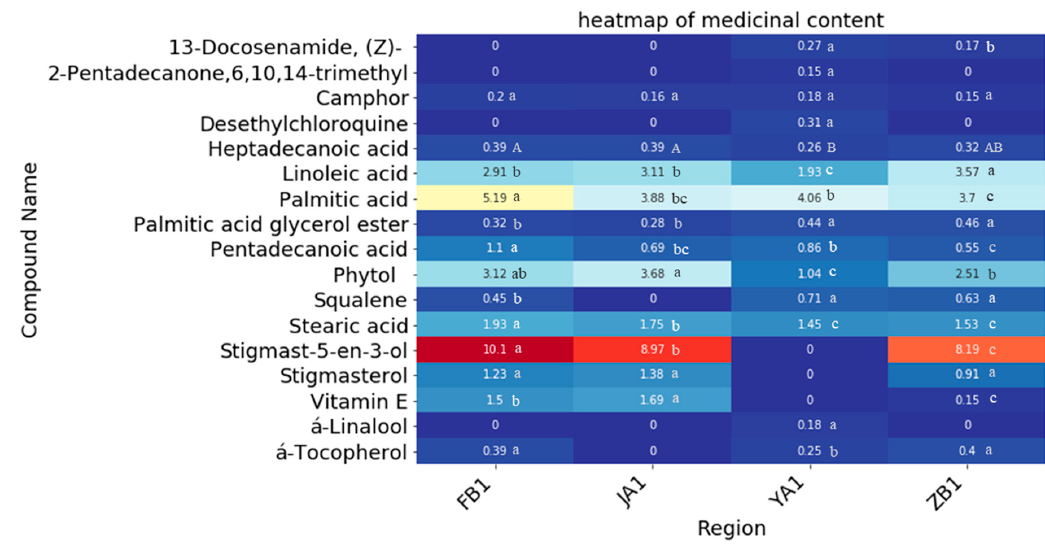
Figure 2. The relative levels of medicinal components di ff ered in D. o ffi cinale in four di ff erent regions from GC-MS data (ZB1, FB1, YA1 and JA1). Capital letters A and B indicate significant di ff erences at p < 0.01, and lowercase letters a, b, and c indicate extremely significant di ff erences at p <